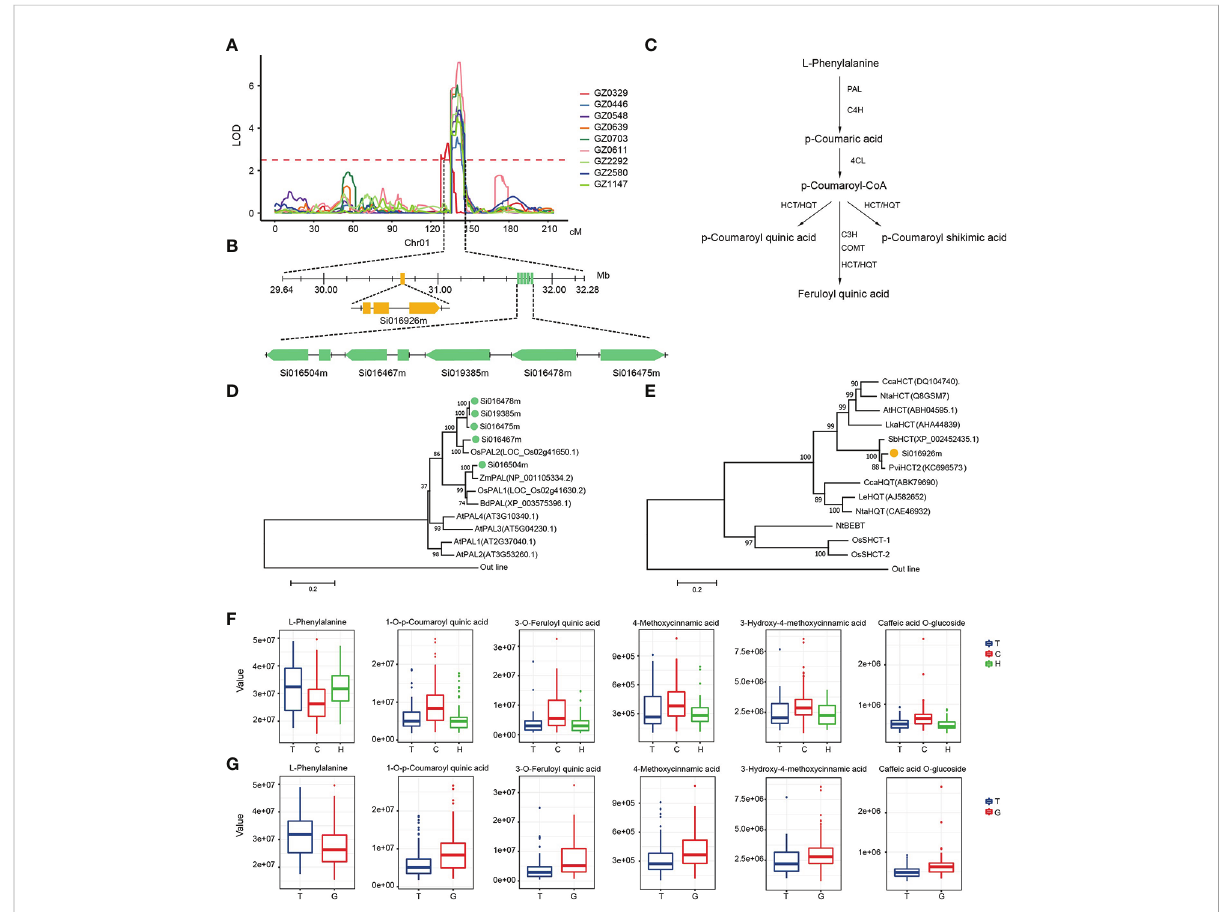
FIGURE 3 Candidate genes for a mQTL hotspot on chromosome 1 for phenylpropanoid metabolites. (A) LOD curves of QTL mapping of the phenylpropanoid metabolites accumulation on chromosome 1. (B) Gene model of candidate genes. The orange box represents the coding sequence of HCT , the green boxes represent the coding sequence of PALs . (C) Metabolic pathways of phenylpropanoid metabolites. (D, E) An unrooted phylogenetic tree of the candidate genes protein was constructed as described in Methods. Bootstrap values >70% (based on 1,000 replications) are indicated at each node (bar: 0.2 amino acid substitutions per site). (F, G) The effect of different alleles on the content of some phenylpropanoid metabolites. GZ0329, L-Phenylalanine; GZ0446, 3-O-p-coumaroyl quinic acid O-hexoside; GZ0548, 1-O-p-Coumaroyl quinic acid; GZ0639, 5-O-p-Coumaroyl quinic acid; GZ0703, 3-O-p-Coumaroyl quinic acid; GZ0611, Caffeic acid O-glucoside; GZ2292, 3-O-Feruloyl quinic acid; GZ2580, 3-Hydroxy-4-methoxycinnamic acid; GZ1147, 4-Methoxycinnamic